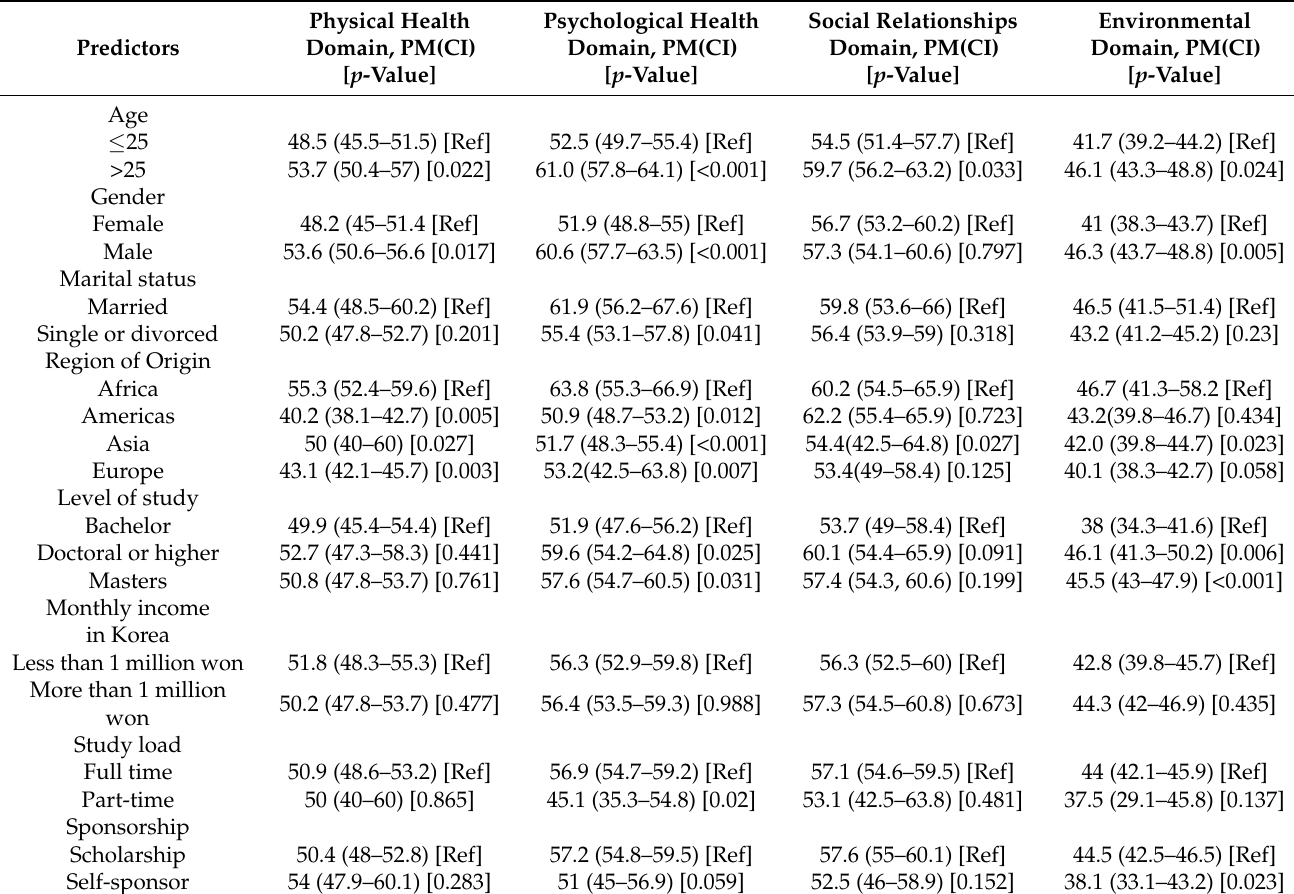
Table 3. Associations between quality of life of international students and sociodemographic